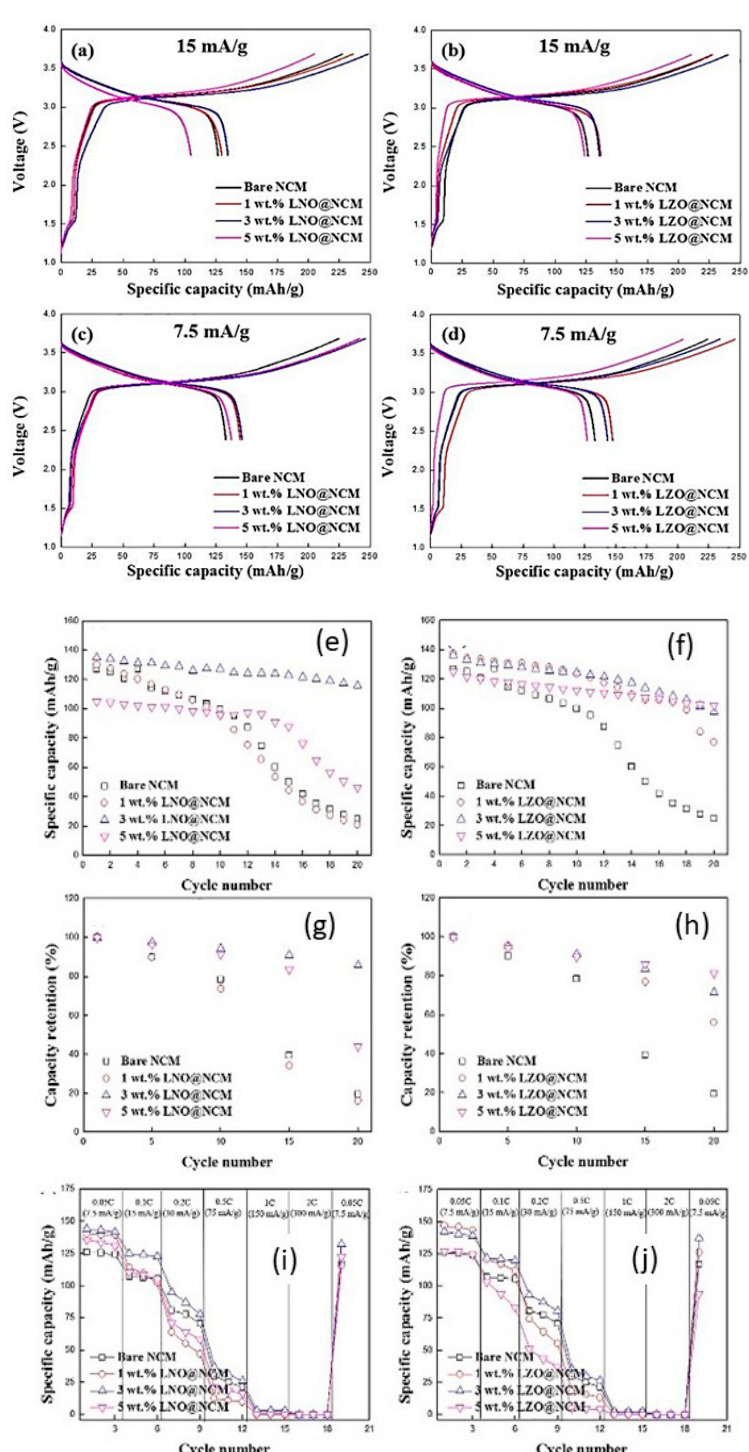
Figure 16. Charge–discharge curves of ( a ) LiNbO 3 (LNO)-coated LiNi 0.8 Co 0.1 Mn 0.1 O 2 (NMC), ( b ) Li 2 ZrO 3 -coated NMC at a current density of 0.1C (current rate of 15 mA g − 1 ), and ( c ) LNO-coated NMC, ( d ) Li 2 ZrO 3 -coated NMC at a current density of 0.05C (current rate of 7.5 mA g − 1 ) obtained using the Li 0.5 In | Li 7 P 2 S 8 I | LiNi 0.6 Co 0.2 Mn 0.2 O 2 cell in the range of 3.68–2.38 V. Cycle performances of: ( e ) LNO-coated NMC, ( f ) Li 2 ZrO 3 -coated NMC at a current density of 0.1C (current rate of 15 mA g − 1 ). Cycle retentions of ( g ) LNO-coated NMC and ( h ) Li 2 ZrO 3 -coated NMC. C-rate performances of ( i ) LNO-coated NMC and ( j ) Li 2 ZrO 3 -coated NMC at di ff erent current densities of 0.05, 0.1, 0.2, 0.5, 1, 2, and 0.05C obtained using the Li 0.5 In | Li 7 P 2 S 8 I | LiNi 0.6 Co 0.2 Mn 0.2 O 2 cell in the range of 3.68–2.38 V. Reproduced with permission from [265]. Copyright 2020